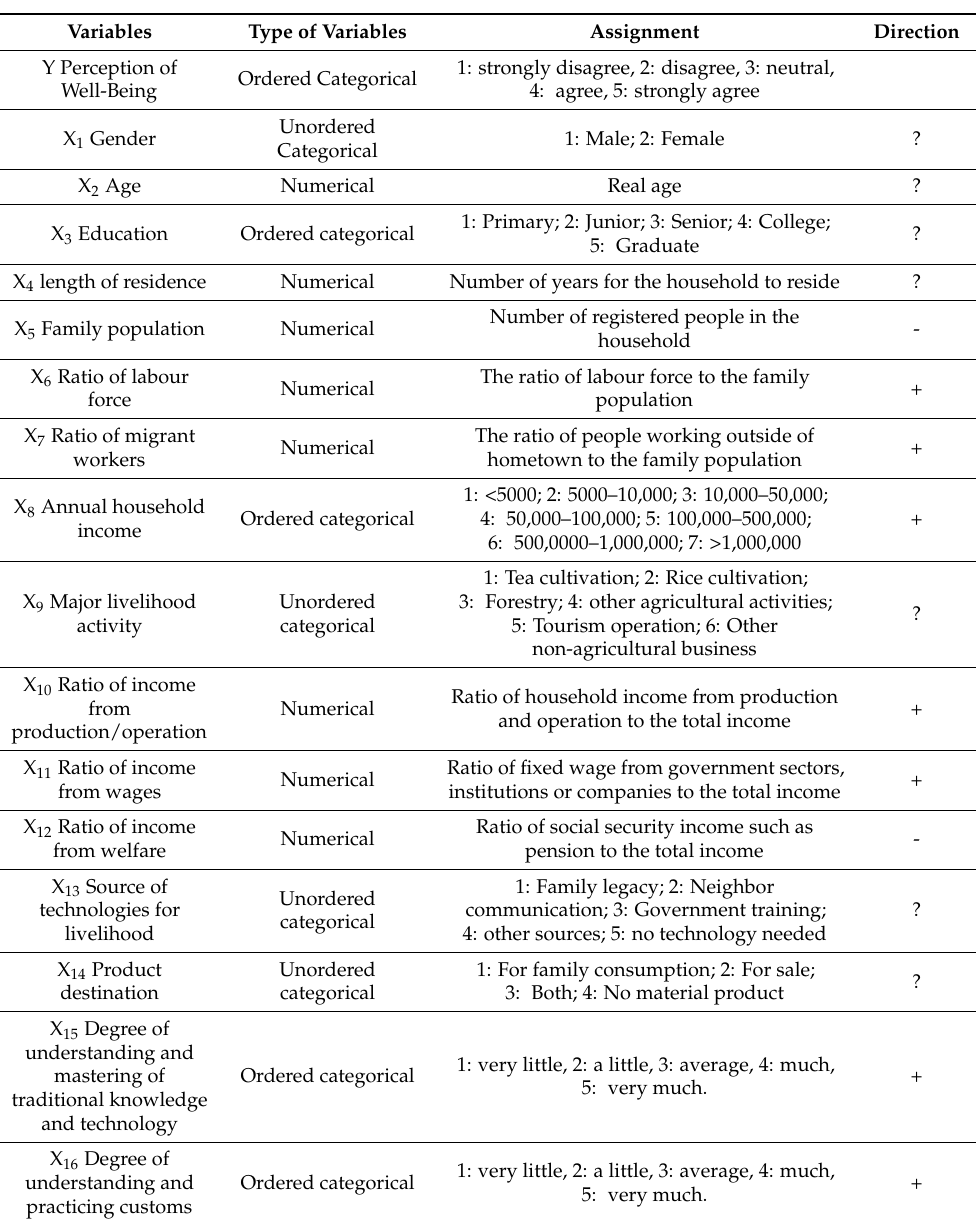
Table 1. Variables and the prediction of impacts of explanatory